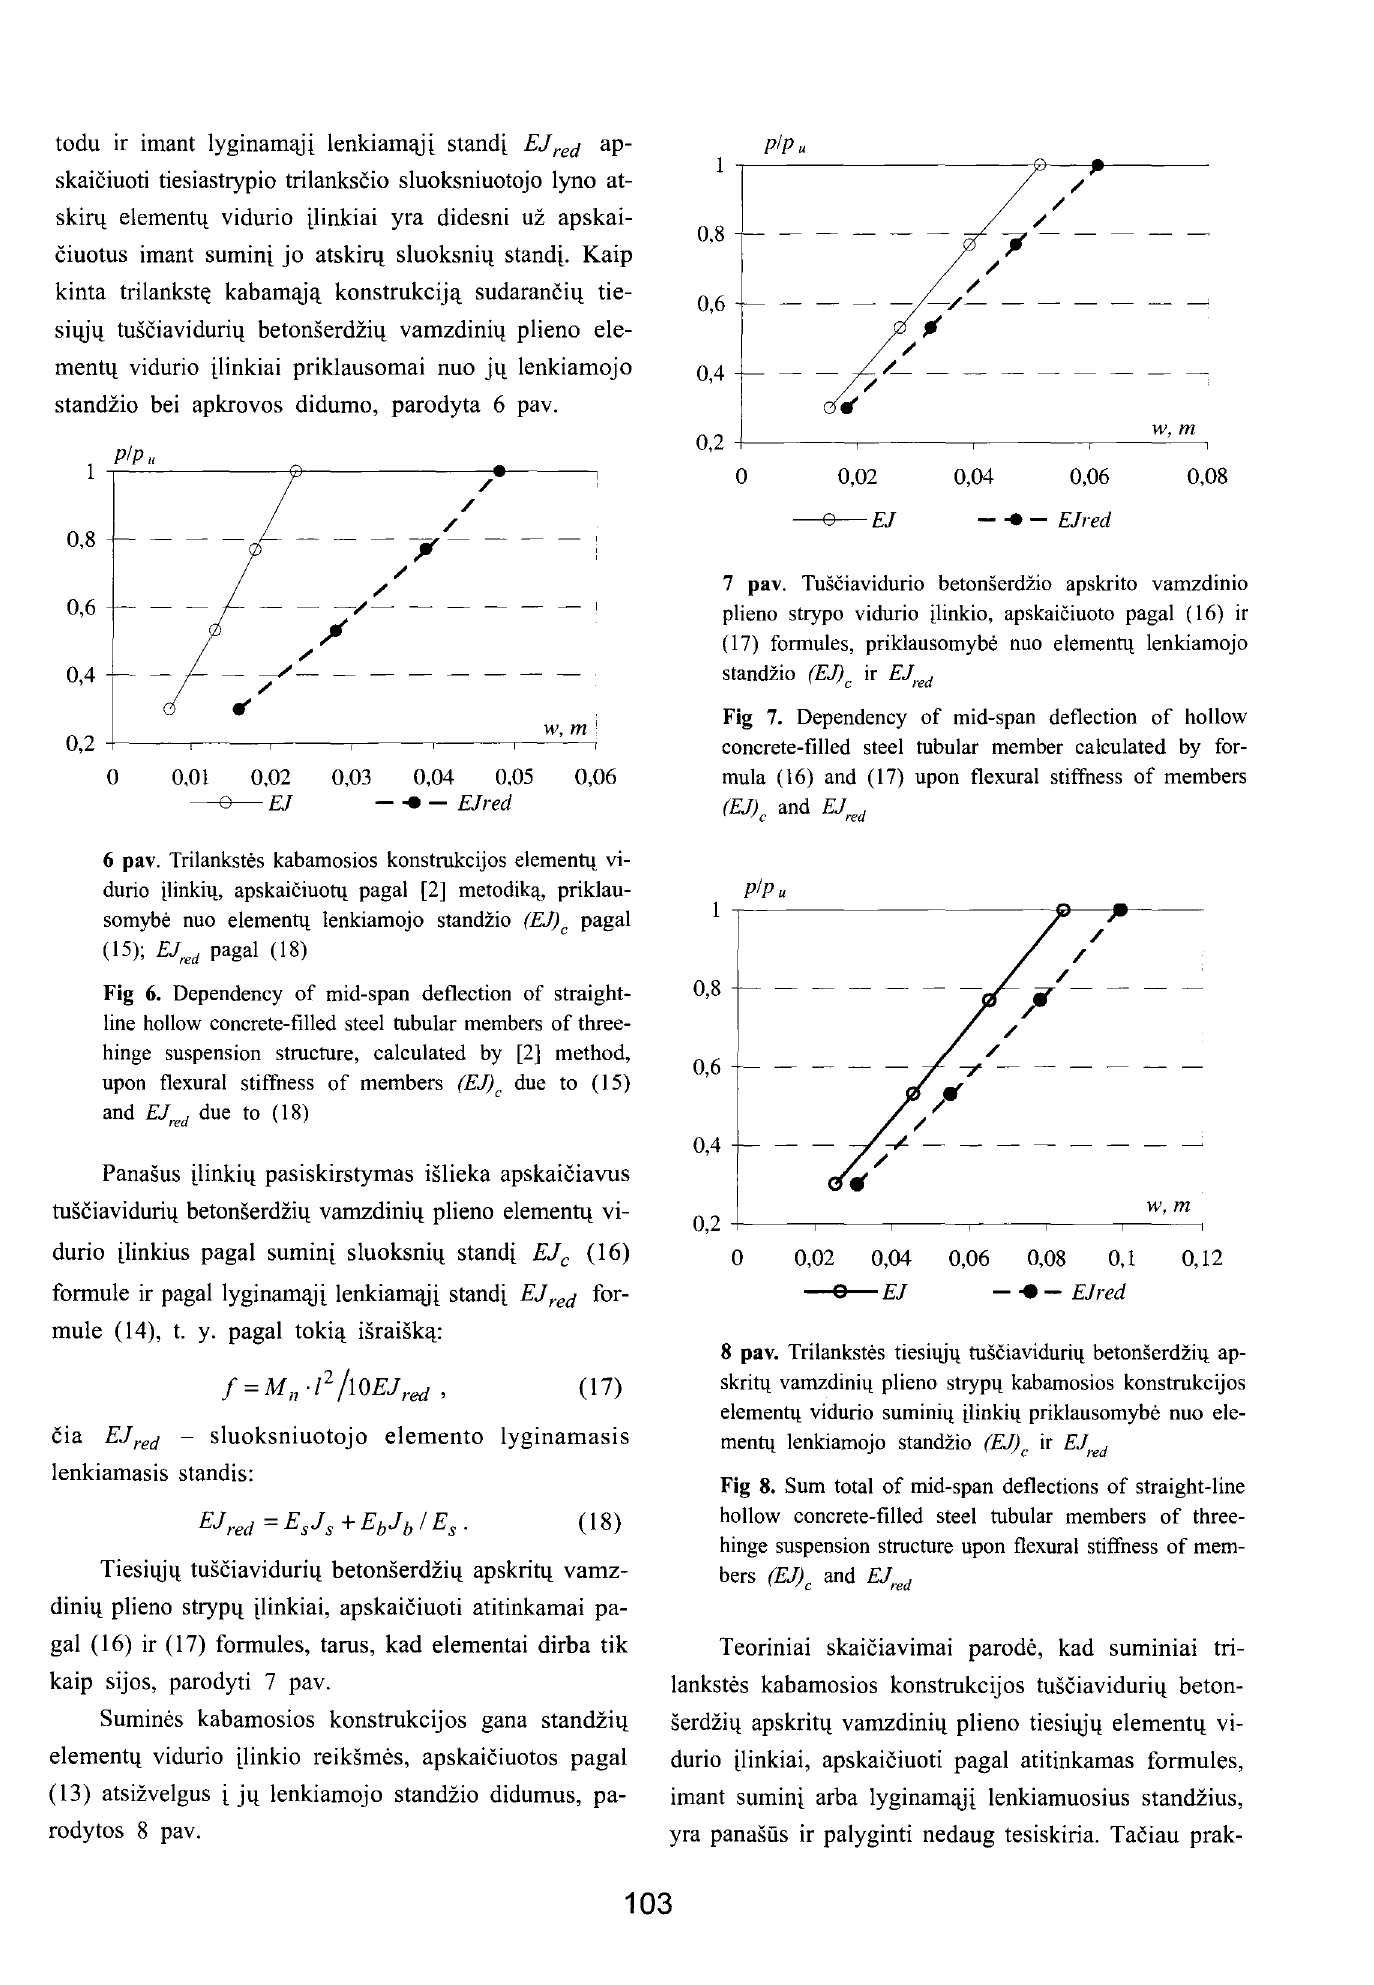
8 pav. Trilankstes tiesil.!ill tusciavidurill betonserdzill ap skritl! vamzdinill plieno strypll kabamosios konstrukcijos element\! vidurio suminill ilinkill priklausomybe nuo ele ment\! lenkiamojo standZio (EJ) c ir EJred Fig 8. Sum total of mid-span deflections of straight-line hollow concrete-filled steel tubular members of three hinge suspension structure upon flexural stiffness of mem bers (EJ) c and